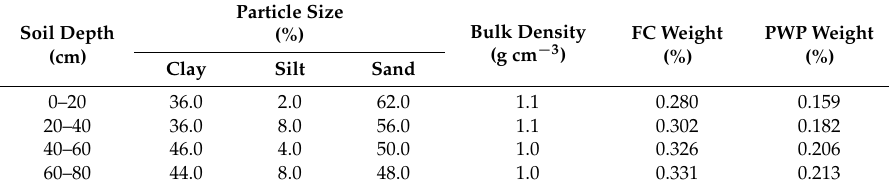
Table 2. Physical properties of different soil layers of the experimental field site.